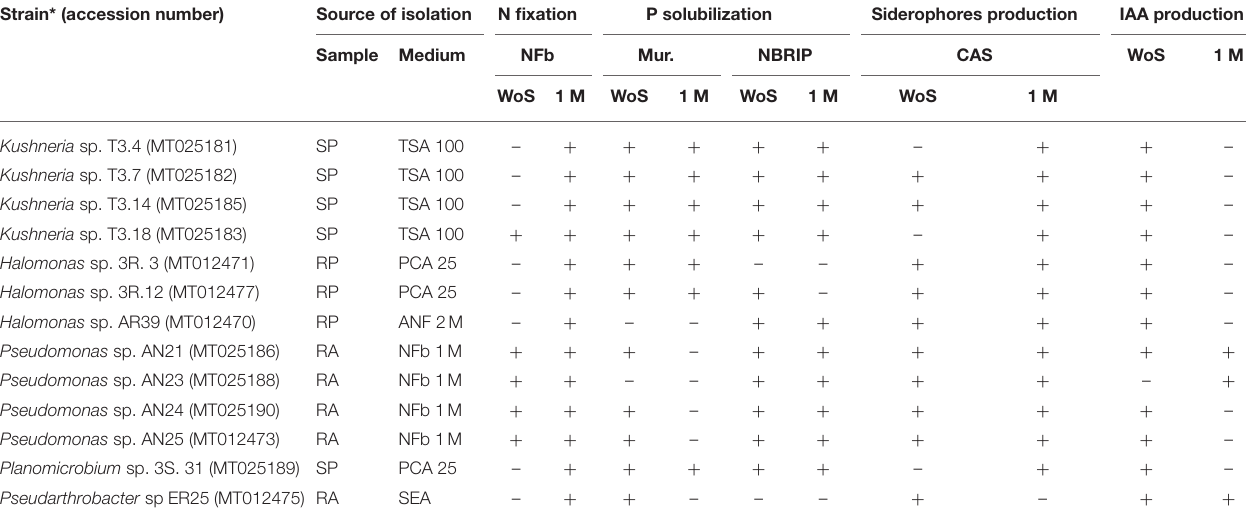
TABLE 2 | Molecular identification by 16S rRNA (with GenBank accession number) and in vitro plant growth-promoting (PGP) properties of bacterial isolates under different saline conditions: without salt (WoS) and with 1M NaCl (1M). Strain* (accession number) Source of isolation N fixation P solubilization